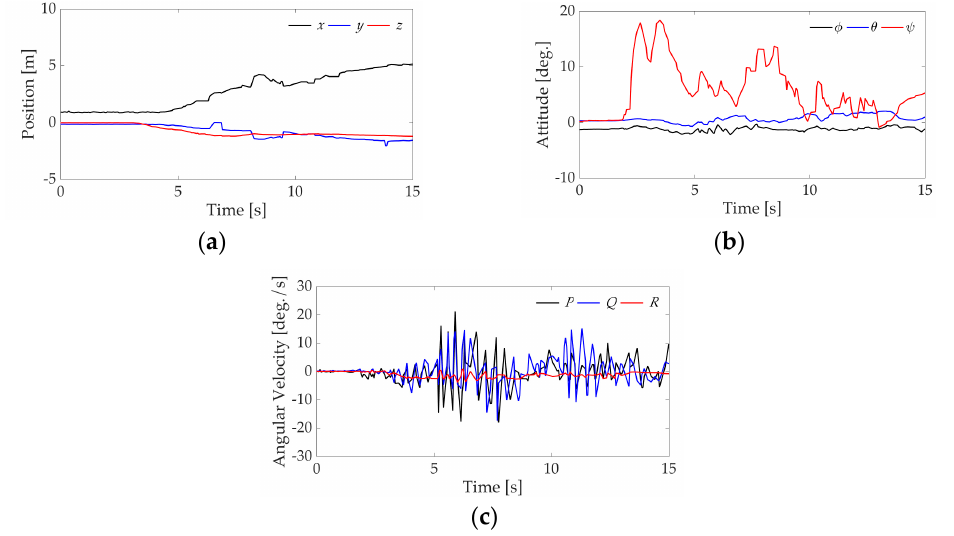
Figure 17. Experimental result of ( a ) position, ( b ) attitude and ( c ) angular velocity using proposed controller.